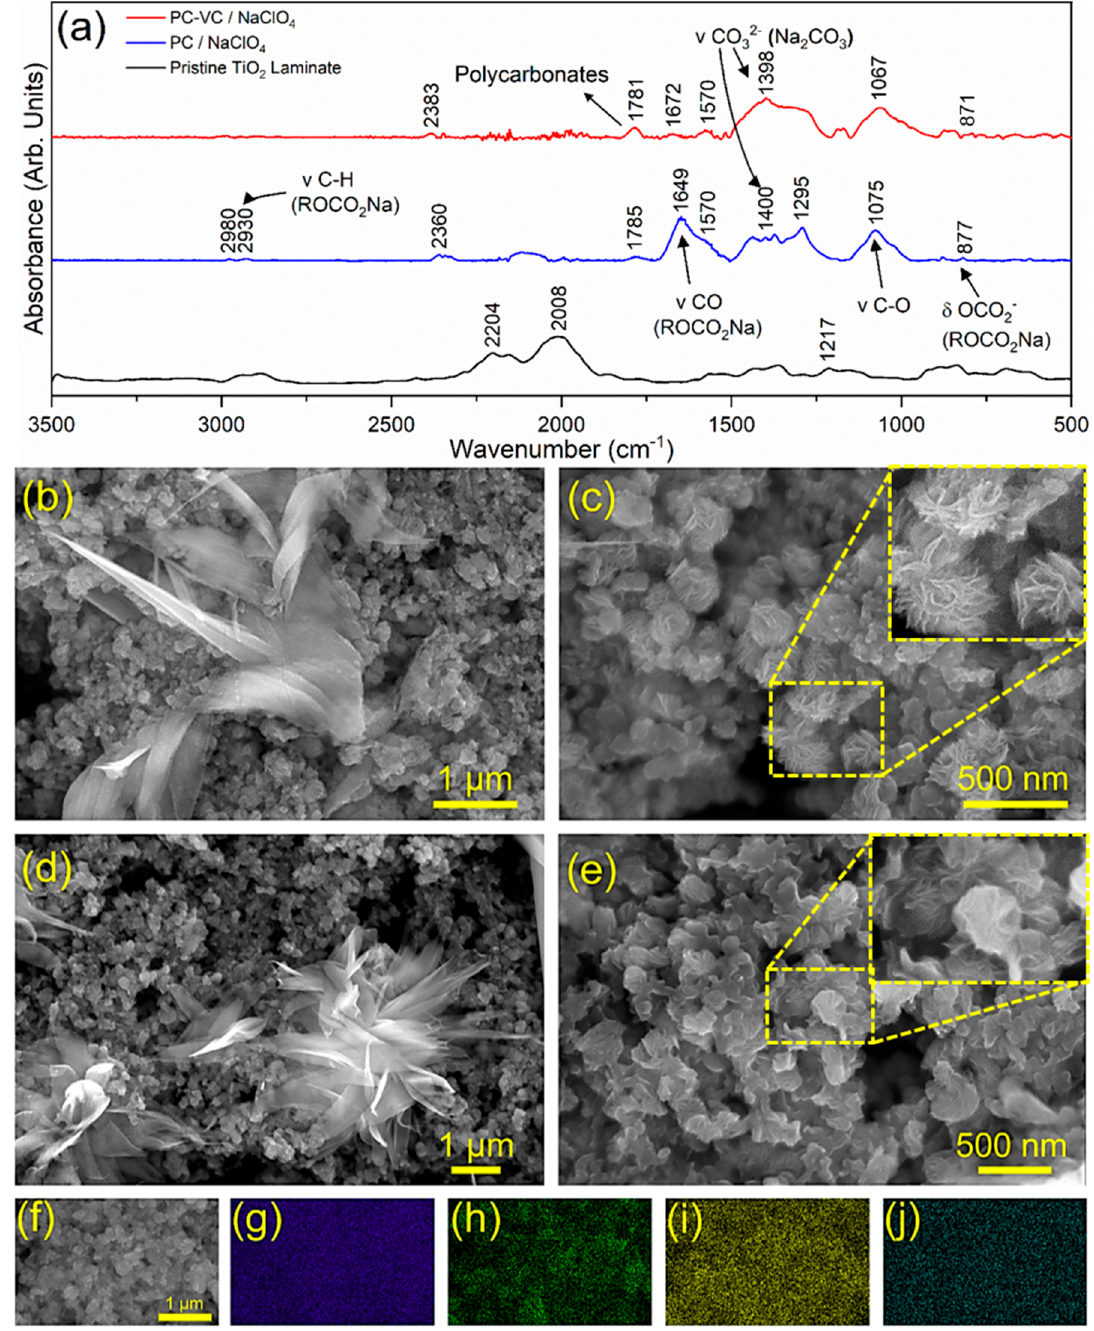
Figure 9. ( a ) ATR-FTIR spectra of non-cycled TiO 2 nanosheet electrodes, and after cycling in PC/NaClO 4 and PC- VC/NaClO 4 electrolyte solutions. Post-cycling SEM images of TiO 2 nanosheet electrodes in ( b , c ) PC/NaClO 4 , and ( d , e ) PC- VC/NaClO 4 electrolyte solution. ( f ) SEM image and ( g – j ) corresponding SEM-EDX elemental mapping of TiO 2 nanosheet electrodes after 30 cycles in PC-VC / NaClO 4 electrolyte solution.